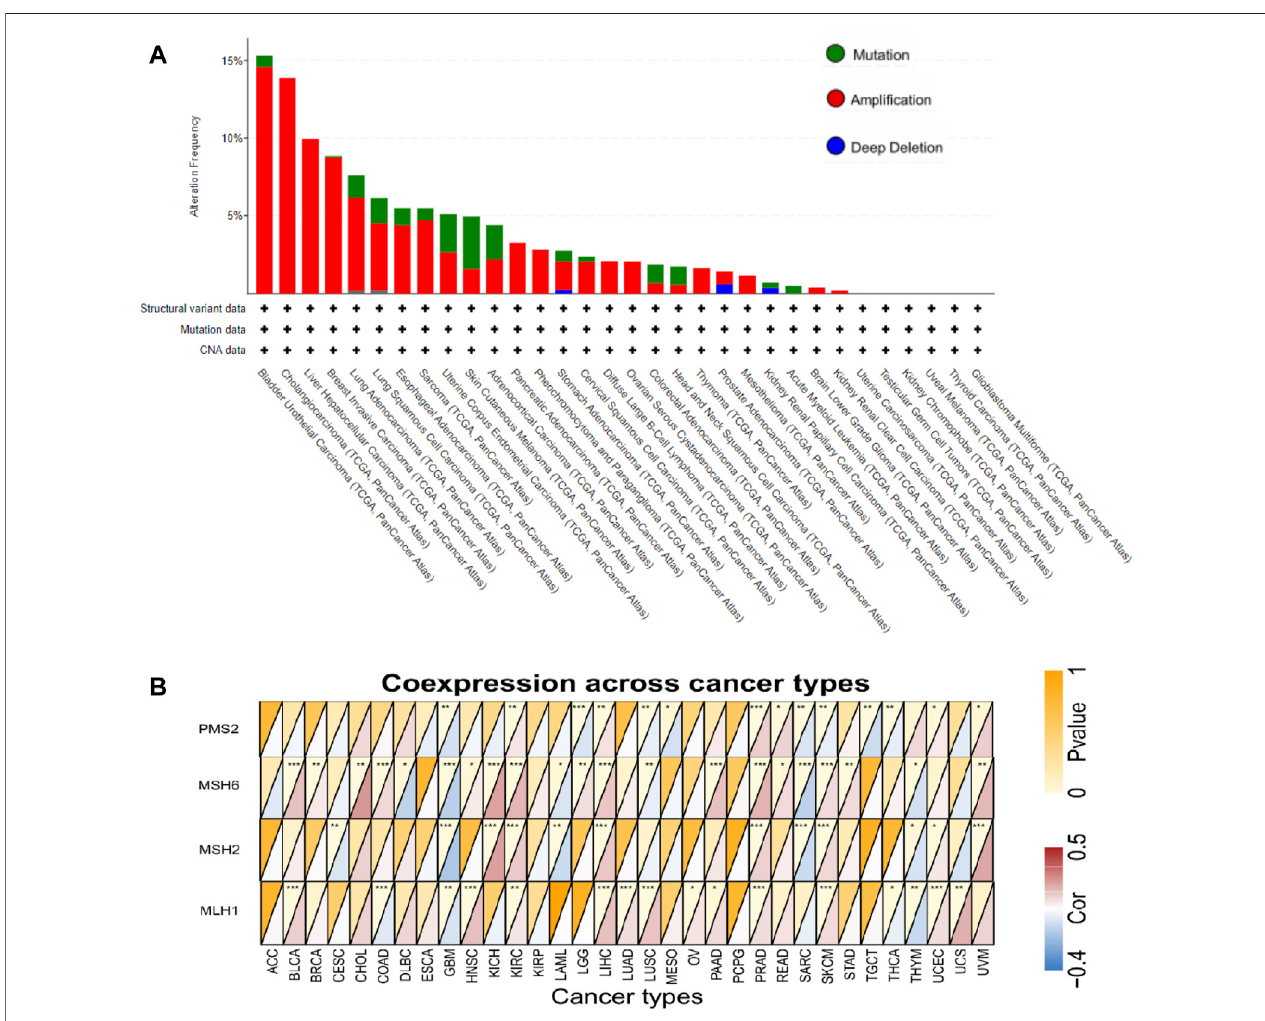
FIGURE6| Mutationcharacteristics ofFCGR3AindifferentTCGAtumors anditsrelationshipwithDNAmismatchrepairgenes(MMRs). (A) Alterationfrequencyof FCGR3Amutationtypesindifferenttumors; (B) HeatmapsshowedtheassociationofAPOC1expressionwithexpressionlevelsoffourMMRsgenesinvariouscancers. * p < 0.05; ** p < 0.01; *** p <